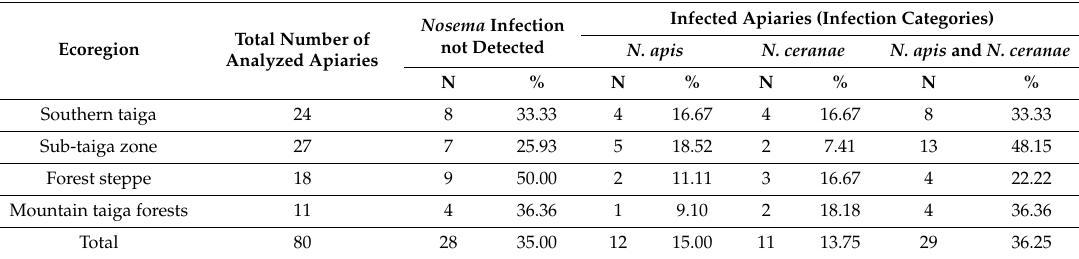
Table 2. Prevalence of colonies infected with only N. apis ( N. apis ) or only N. ceranae ( N. ceranae ) or coinfection ( N. apis and N. ceranae ) in apiaries in several ecoregions of North Asia from spring 2016 to autumn 2017.